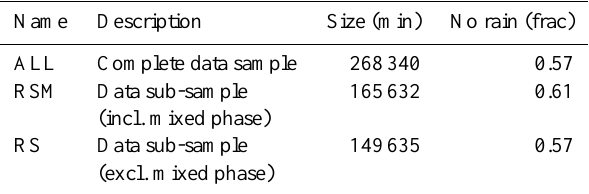
Table 2. OceanRAIN data sets from RV Polarstern divided into sub-data sets that are used in the analysis. While RSM (rain, snow, mixed phase) and ALL (all data) include the mixed phase, RS (rain, snow) sub-data exclude mixed-phase precipitation. RSM and RS include only those minutes with at least 20 particles of precipita- tion falling at mid- or high latitudes at air temperatures around the freezing point (see Sect. 2.3). The no-rain fraction (rain fraction subtracted from 1) yields the fraction frozen precipitation meaning snow cases for RS and snow and mixed phase for RSM and ALL.